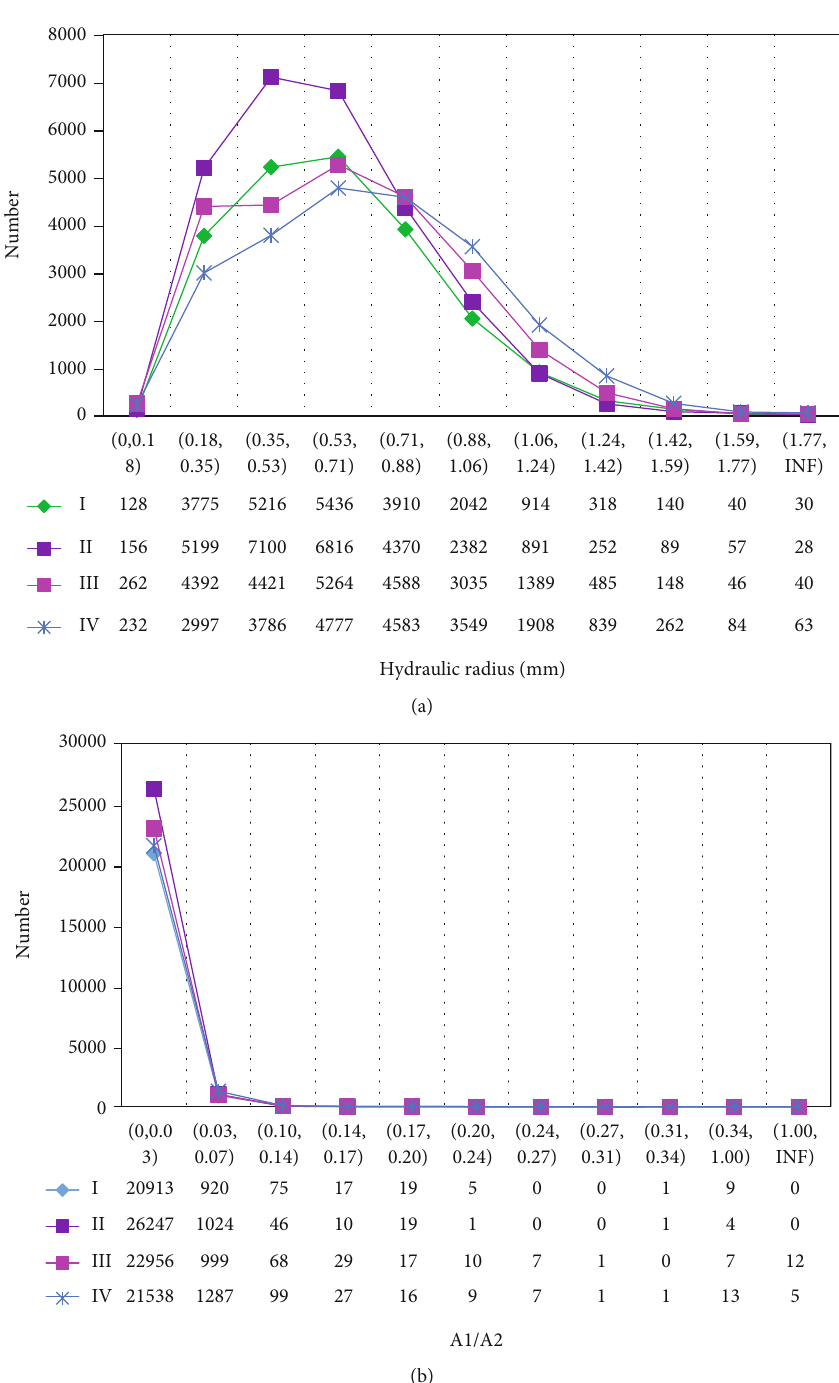
Figure 7: Distribution of hydraulic radius and A